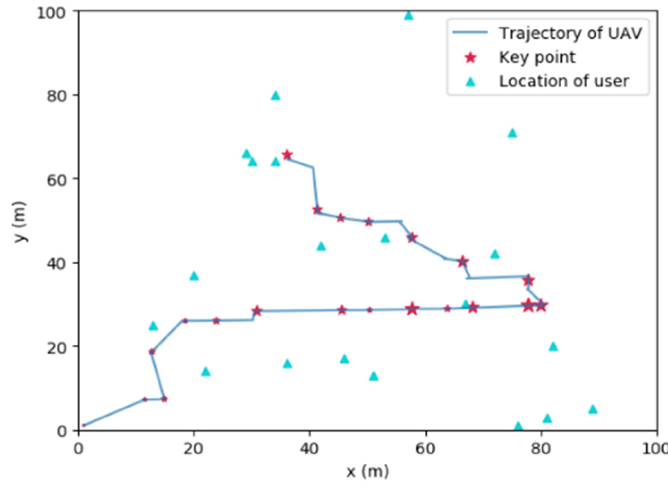
Figure 6. The trajectories of the UAV.